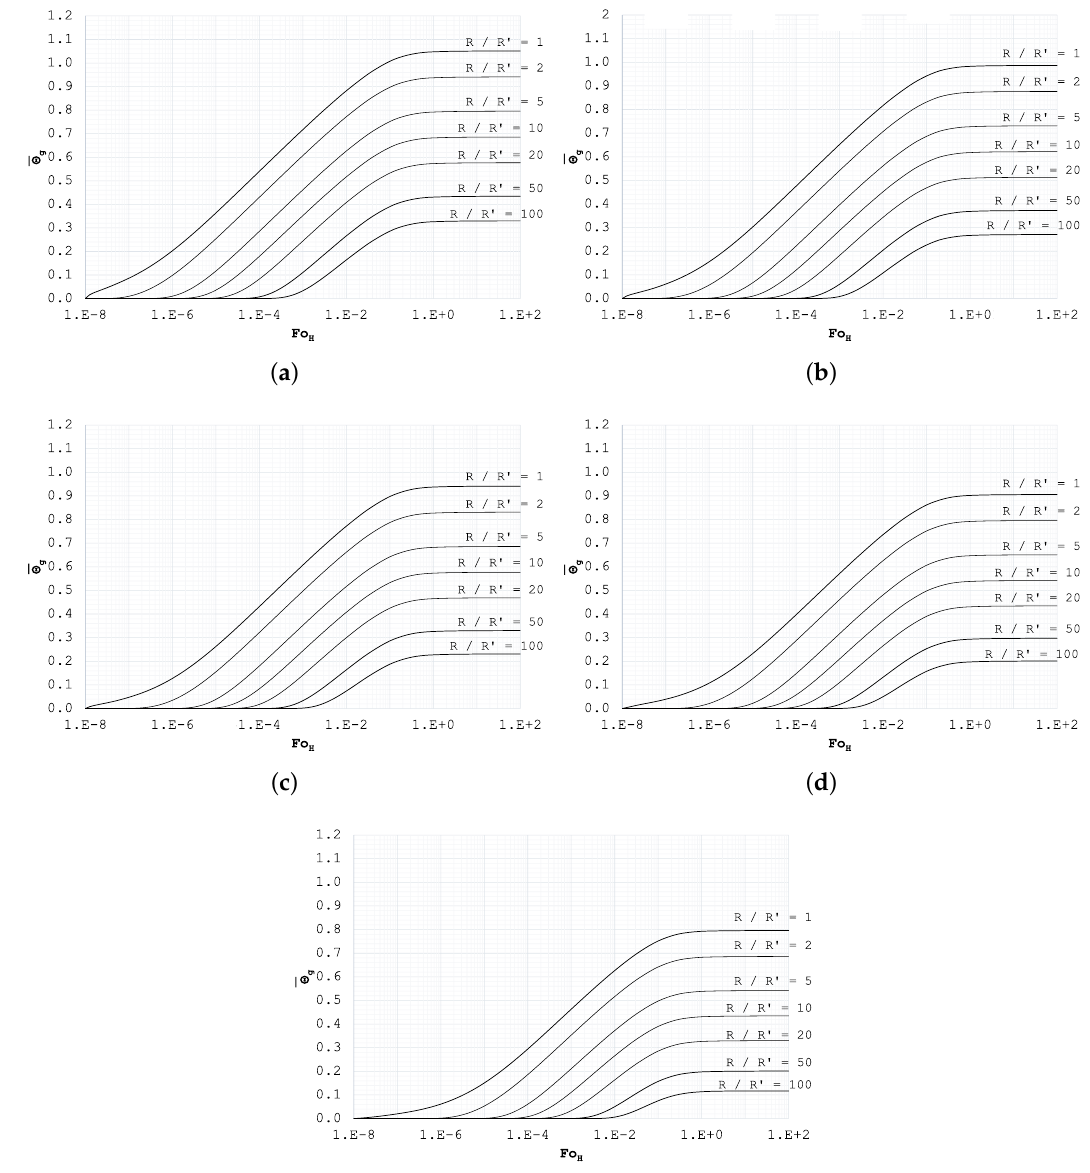
Figure 9. Dimensionless temperature, Θ g , as a function of Fo H , BHE aspect ratio, R (cid:48) = r b / H b , and dimensionless radial distance from the BHE, R / R (cid:48) = r / r b . ( a ) R (cid:48) = 1/2000; ( b ) R (cid:48) = 1/1330; ( c ) R (cid:48) = 1/1000; ( d ) R (cid:48) = 1/800; ( e )